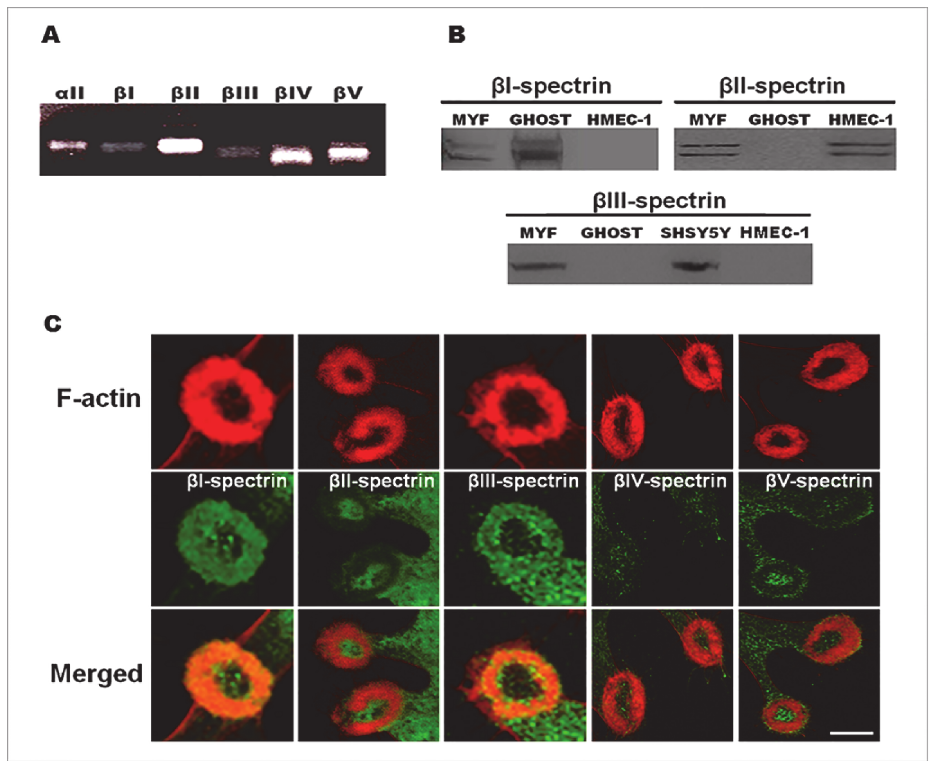
Fig 2. α II β I- and α II β III-spectrin heterodimers are specifically present in invadosomes. (A) RT-PCR products analysis of β -spectrin chains. The presence of β -spectrin mRNAs ( β I, β II, β III, β IV, β V) was investigated using extracted RNA from total lysates of SrcY527F-MEF cells. Higher expression of β II-, β IV- and β V-spectrin chains was found in these cells. (B) Detection of β -spectrin expression at the protein level in SrcY527F-MEF cells (MYF). Western blotting was performed from 20 μ g of proteins of MYF cells and compare to a β I-spectrin positive control from a preparation of red blood cells membranes (GHOST, 0,7 μ g per lane), to a β II-spectrin positive control from a preparation of HMEC-1 endothelial cells (20 μ g per lane) and to a β III-spectrin positive control from a preparation of SHSY5Y neuronal cells (20 μ g per lane). β I- spectrin, conventional β II- and β III-spectrins were detected in SrcY527F-MEF cells. (C) SrcY527F-MEF cells were fixed and stained for the different β -spectrin chains (green) and invadosome structures were visualized by F-actin staining (red). β I- and β III-spectrins are specifically enriched in invadosome rings while β II-, β IV- and β V-spectrins are not present. Scale bar: 5 μ